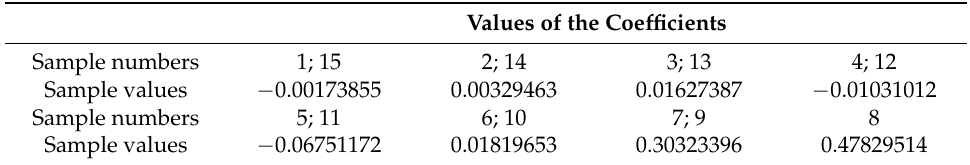
Table 6. Impulse response of the 15th order